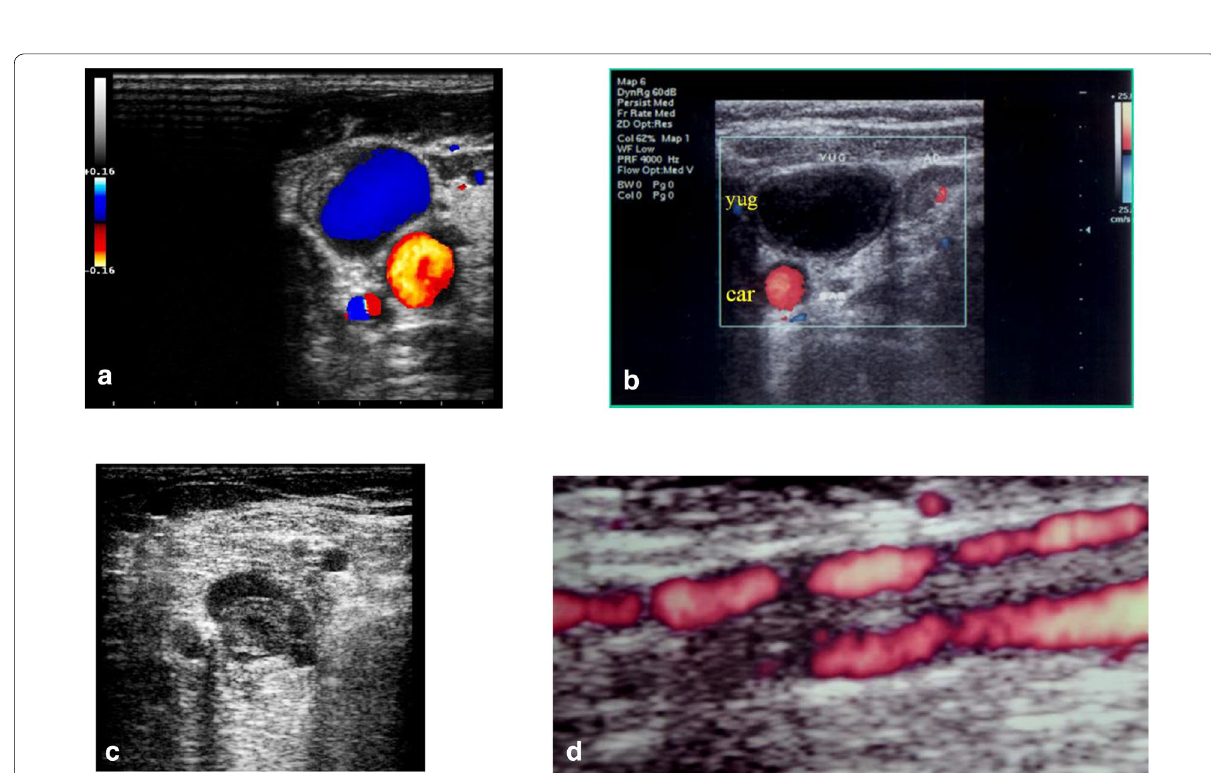
Fig. 7 Venous thrombosis. a Partial thrombosis of right yugular vein: color Doppler (jugular vein in blue , carotid artery in red ). b Complete acute hypoechoic thrombosis of left jugular vein (yug): transverse view. Carotid artery is seen in red (car). c Post trauma partial venous thrombosis. d Chronic thrombosis: partial recanalization: multiple color tunnels are seen inside the